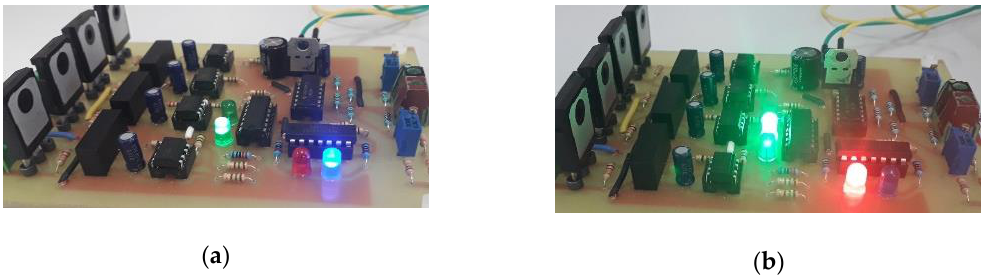
Figure 7. Bipolar converter images under different detection stages: ( a ) minimum voltage level reached and the 0° movement is performed, and ( b ) the maximum voltage level reached and the 90° movement is performed.